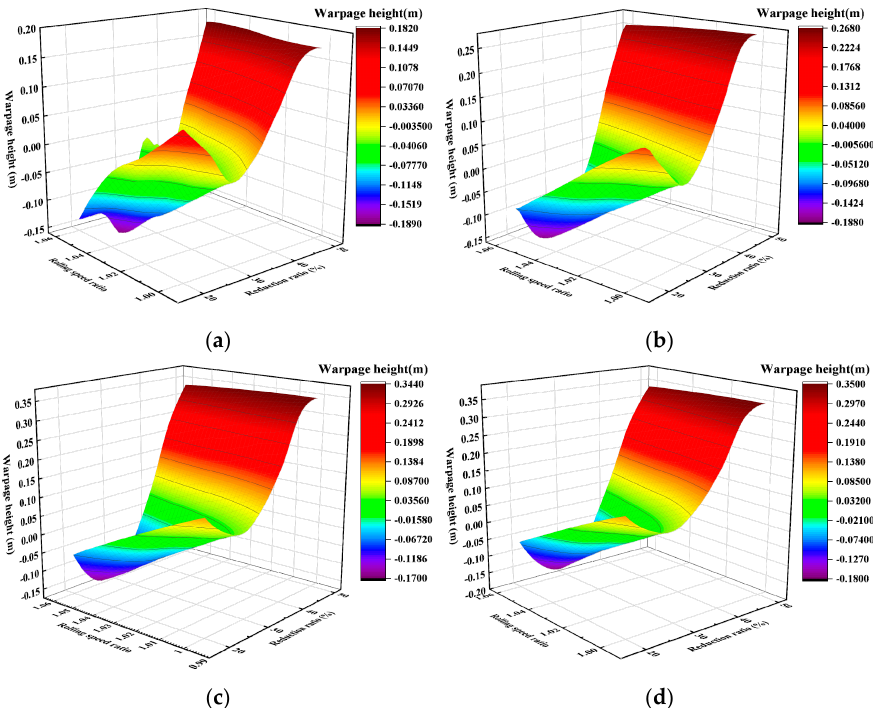
Figure 13. Simulation results of the warpage height for different roll speed ratios and different reduction ratios. ( a ) Thickness ratio = 0.11, ( b ) thickness ratio = 0.25, ( c ) thickness ratio = 0.67, ( d ) thickness ratio =